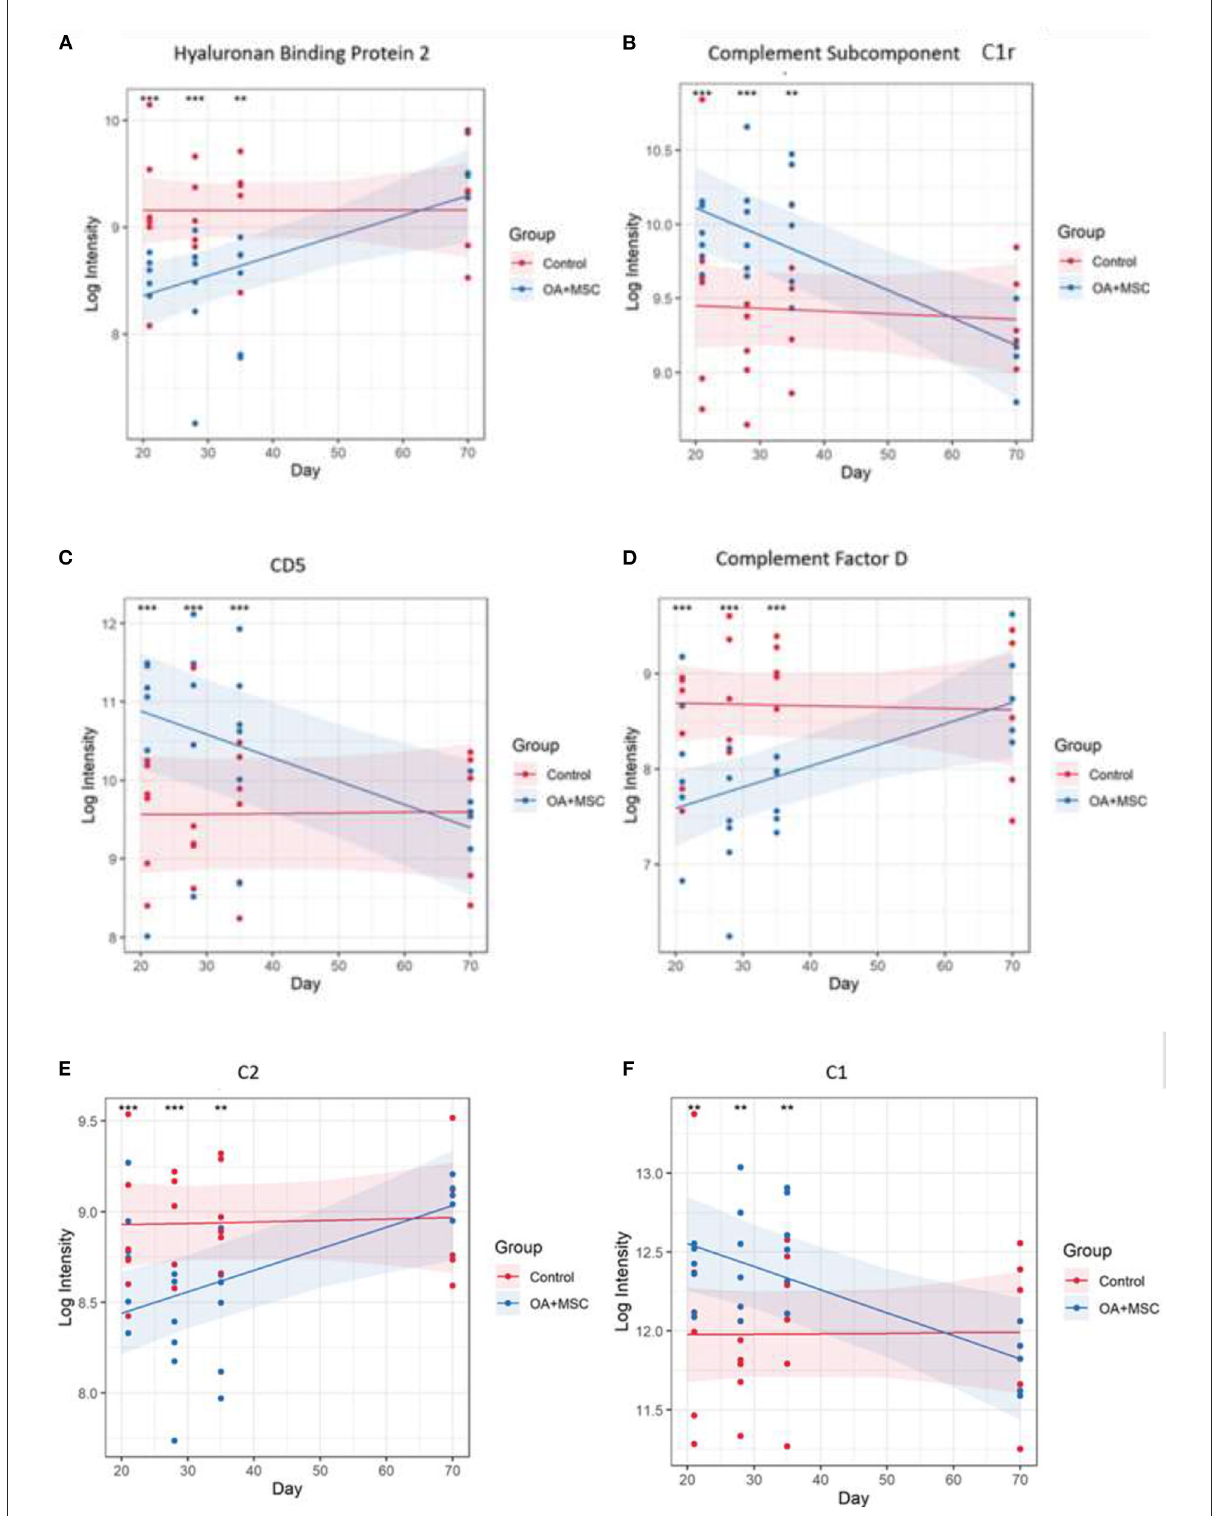
FIGURE6 Protein expression changes in response to MSC treatment in OA joints vs control. (A) Hyaluronan binding protein 2, (B) Complement subcomponent C1r, (C) CD5, (D) Complement factor D, (E) C2, and (F) C1. The models were fitted using the lmerTest implementation of lme4.